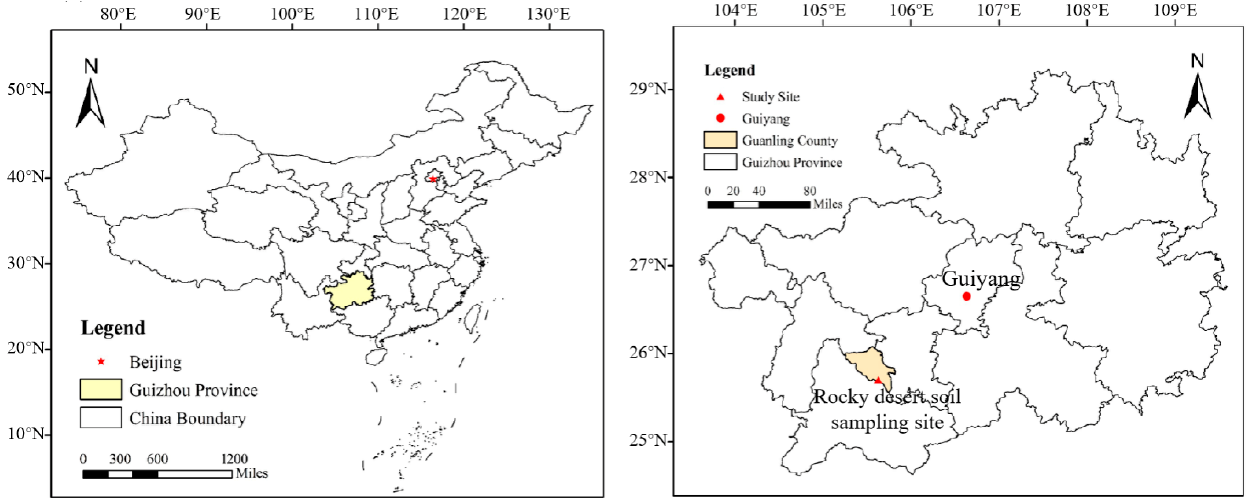
Figure 1. Location of soil sample plot at different bedrock exposure rates in karst rocky desertifica- tion